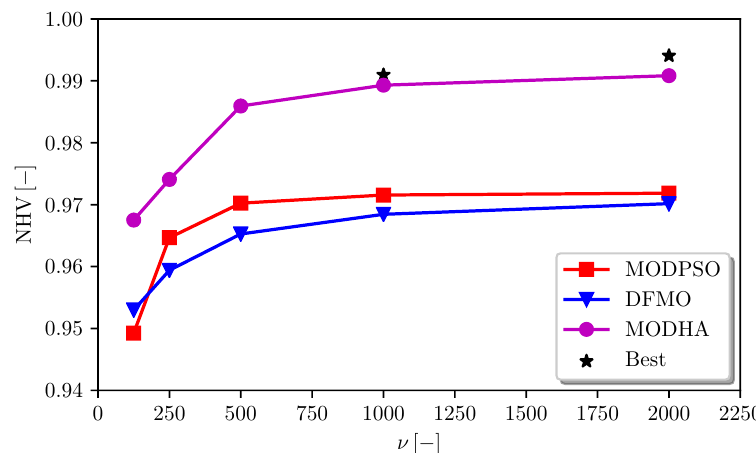
Figure 8. Comparison of MODHA average performance (on the analytical test problems) to MODPSO and DFMO. Table 2. MODHA average performance along with comparison to MODPSO and DFMO: test problems NHV mean values and (in parenthesis) standard deviation. MODHA Computational Budget Coefficient γ Parameters 125 250 2000 Average